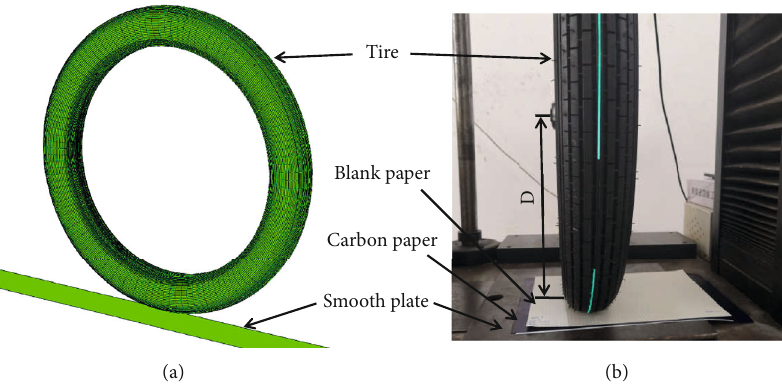
Figure 3: 2.75-18 TWM tire: (a) fi nite element model; (b) test.